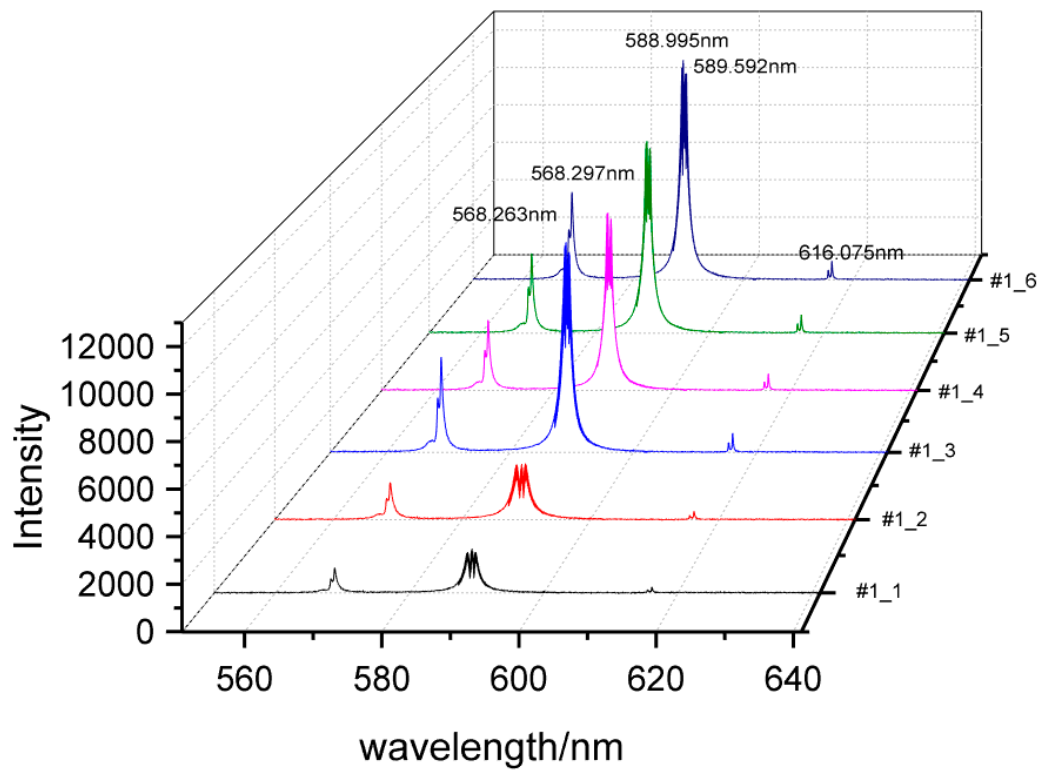
Figure 2. Spectra intensity of samples #1-1 to #1-6 at an energy intensity of 3.8 J / cm 2 shown in black, red, navy blue, green, light blue, and purple, respectively.